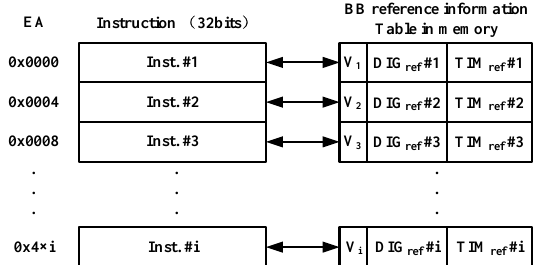
Figure 4. The data structure of BB reference information